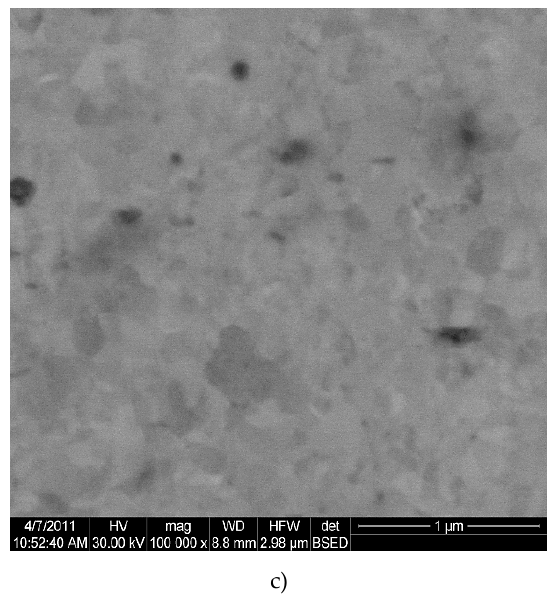
Figure 15. BSED microscopy image of composites sintered at 800 ◦ C: ( a ) Cu; ( b )